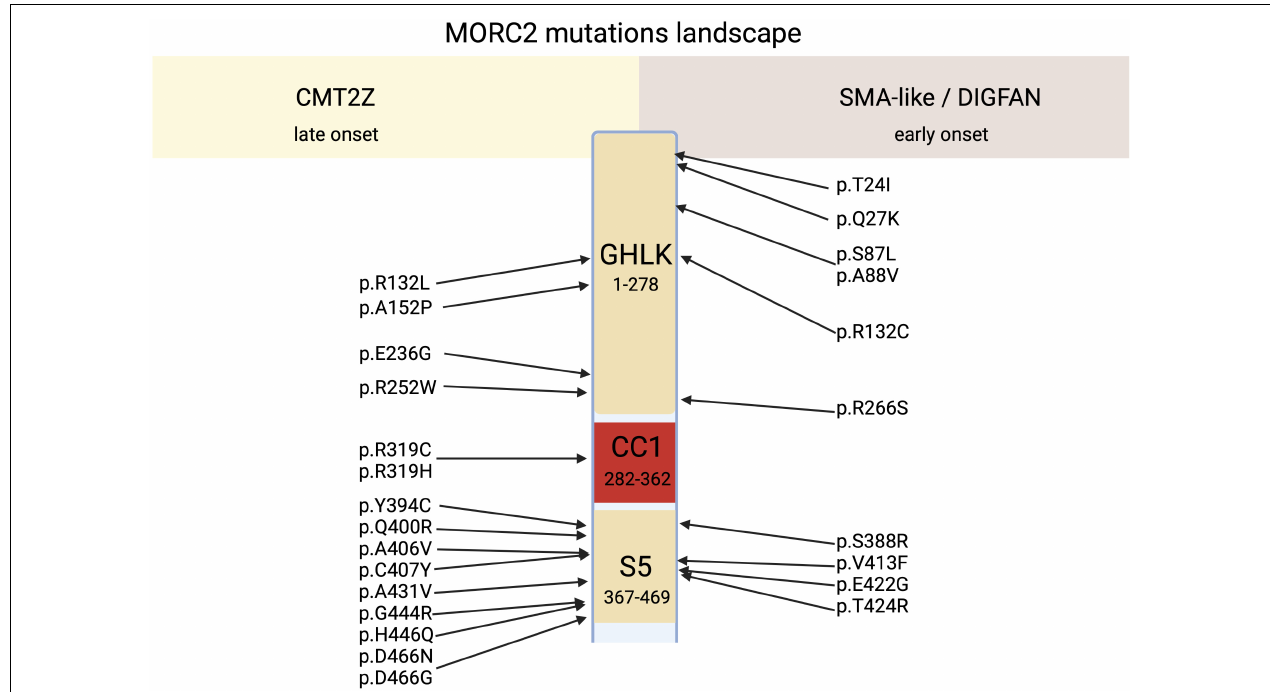
FIGURE 3 | Schematic representation of MORC2 domains architecture correlated to their related main clinical features, CMT2Z or SMA-like/DIGFAN syndrome.